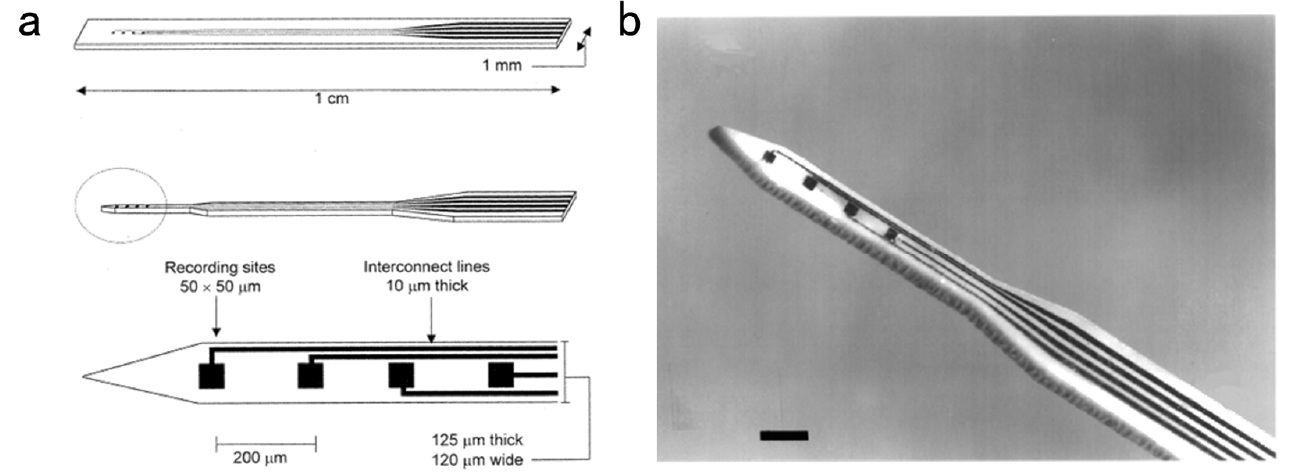
Figure 11. ( a ) Schematic diagram of the rectangular and tapered multi-site and ceramic-based microelectrodes. ( b ) A multi-site ceramic-based microelectrode tip.